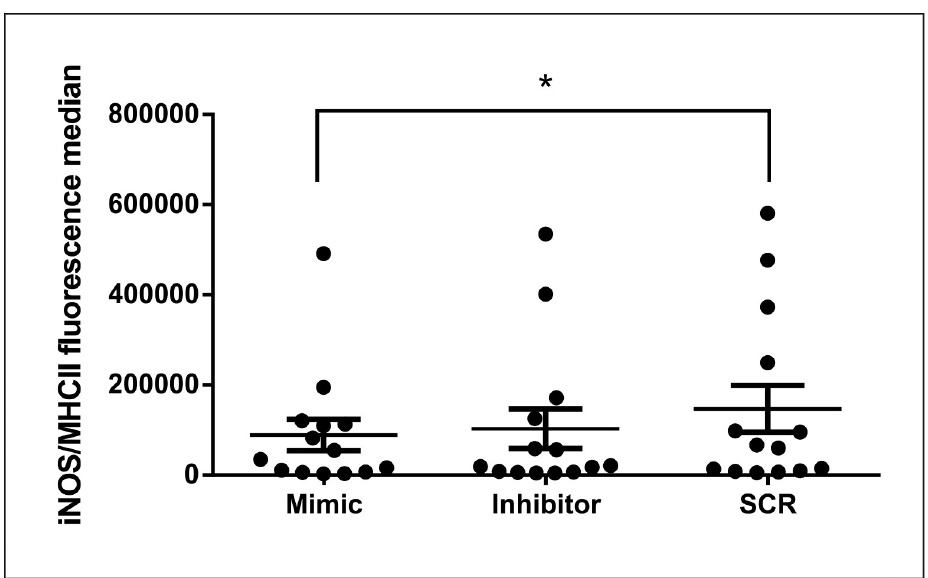
Fig 3. Expression of iNOS in MHCII + leukocyte with mimic or inhibitor of miR-148a. iNOS expression was evaluated in SL from CanL group (dogs naturally infected by L . infantum ) transfected with miR-148a mimic or inhibitor, or SCR and maintained in culture for 48 h at 37˚C and 5% CO 2 . Posteriorly, SL were marked with monoclonal antibodies conjugated to fluorochromes for analyze by flow cytometry. Bars represent iNOS expression median values (45099, 20237 and 63677), 25th (7064, 6716 and 9194) and 75 th (115028, 136904 and 280471) percentile interquartile range of mimic, inhibitor and SCR treatments, respectively. Symbols represent data from individual animals. Asterisks represent significant differences (Friedman test with Dunn’s multiple comparison test, p = 0.008).